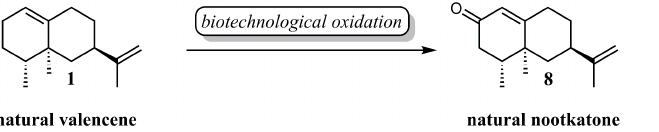
Figure 1. Single oxidation obtaining natural nootkatone ( 8 ) starting from natural valencene ( 1 ).